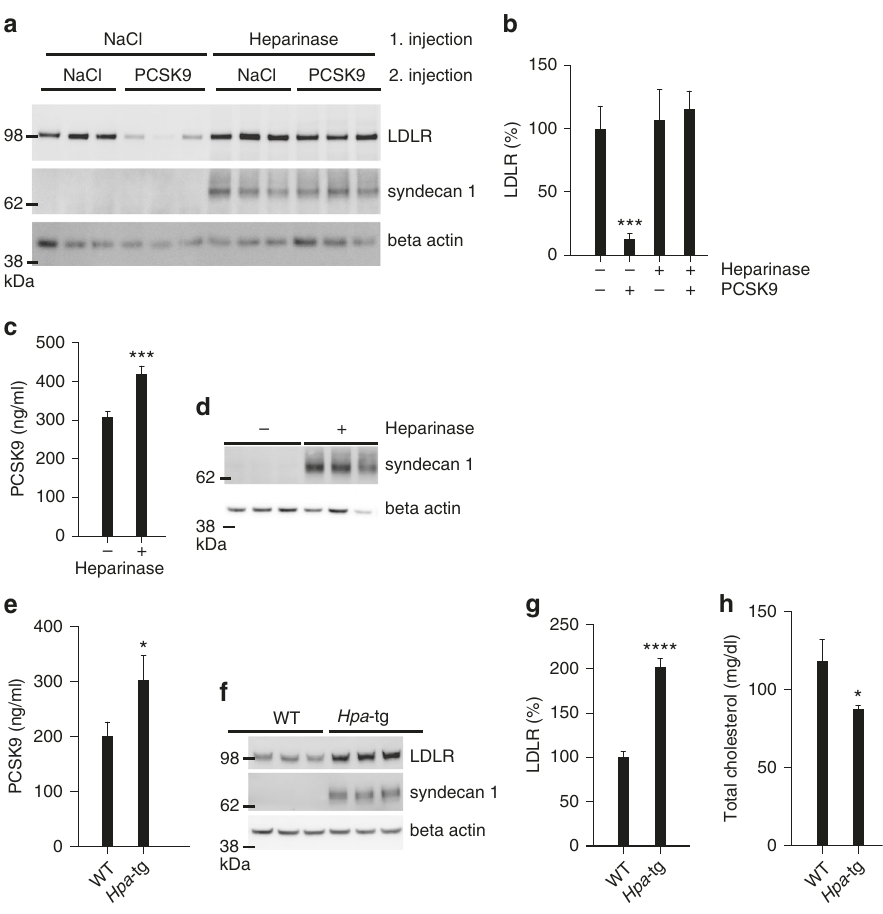
Fig. 6 Enzymatic removal of liver heparan sulfate releases PCSK9 and ablates its activity. a , b Infusion of heparinase I prior to the injection of PCSK9 (10 µ g) completely inhibits PCSK9-induced degradation of LDLR. Western blot of representative samples is shown in a and quanti fi cation of LDLR in b (control n = 7, PCSK9 n = 6, heparinase n = 5, heparinase/PCSK9 n = 5). Heparinase treatment unmasks the antigenicity of the major liver HSPG syndecan-1 ( middle panel ). Beta-actin is used as loading control ( lower panel ). c Heparinase I treatment leads to an increase in plasma PCSK9 as measured by ELISA 15 min after injection (control n = 6, heparinase n = 6). d Western blot (representative samples) of liver syndecan-1 is used as control of heparinase injection. Beta-actin is shown as loading control. e – h Transgenic mice with constitutive expression of human heparanase ( Hpa -tg) ( n = 7) have increased plasma PCSK9 ( e ), increased liver LDLR ( f , g ), and reduced plasma cholesterol ( h ) compared to control WT mice ( n = 6). Bar graphs show mean with s.e.m. error bars. Statistical signi fi cance was evaluated using a two-tailed Student ’ s t -test. Supplementary Fig. 11 shows uncropped gel